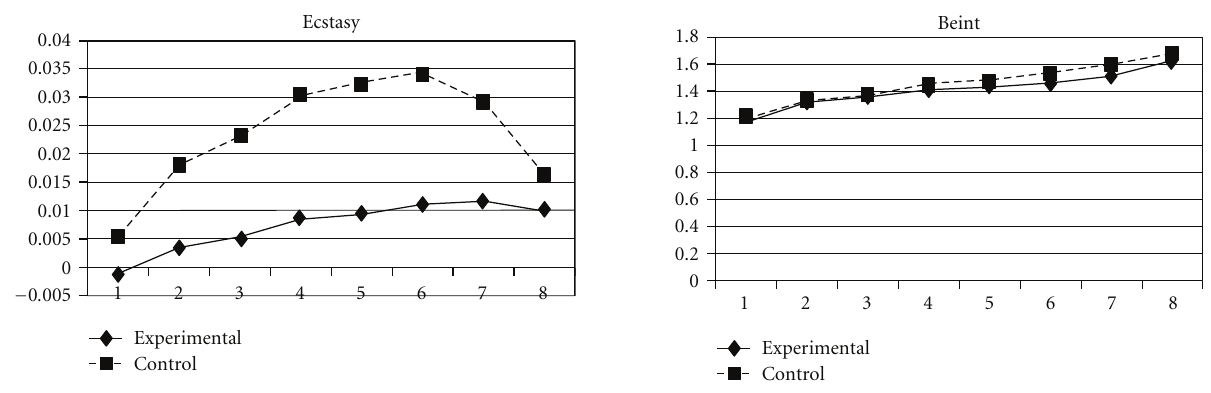
Figure 14: Growth trajectories of the experimental group (all par- ticipants) and control group using the scale score of problem be- havior intention as the outcome indicator.